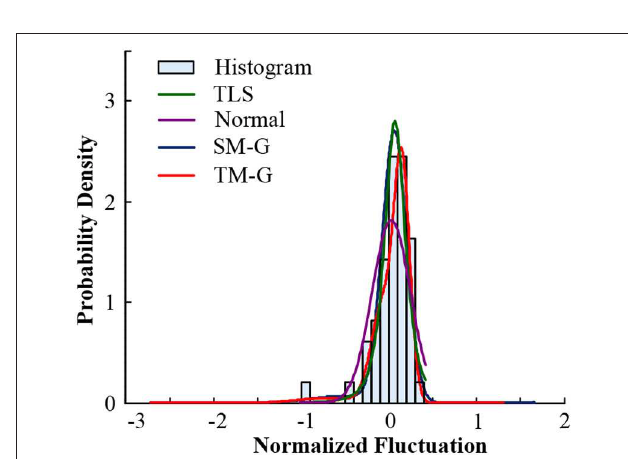
FIGURE 7 | Comparison of probability distribution of volatility components in Xichang City on August 9,